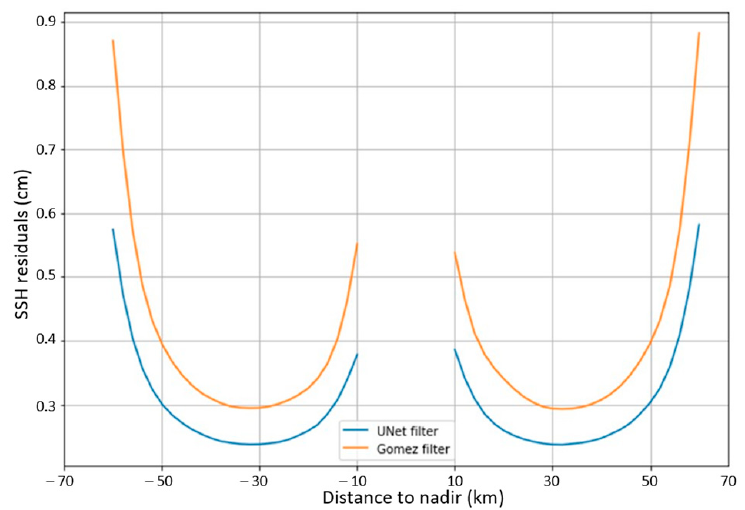
Figure 8. SSH residuals as function of the across-track distance from the nadir. Only data at more than 10 km from the coast are considered.